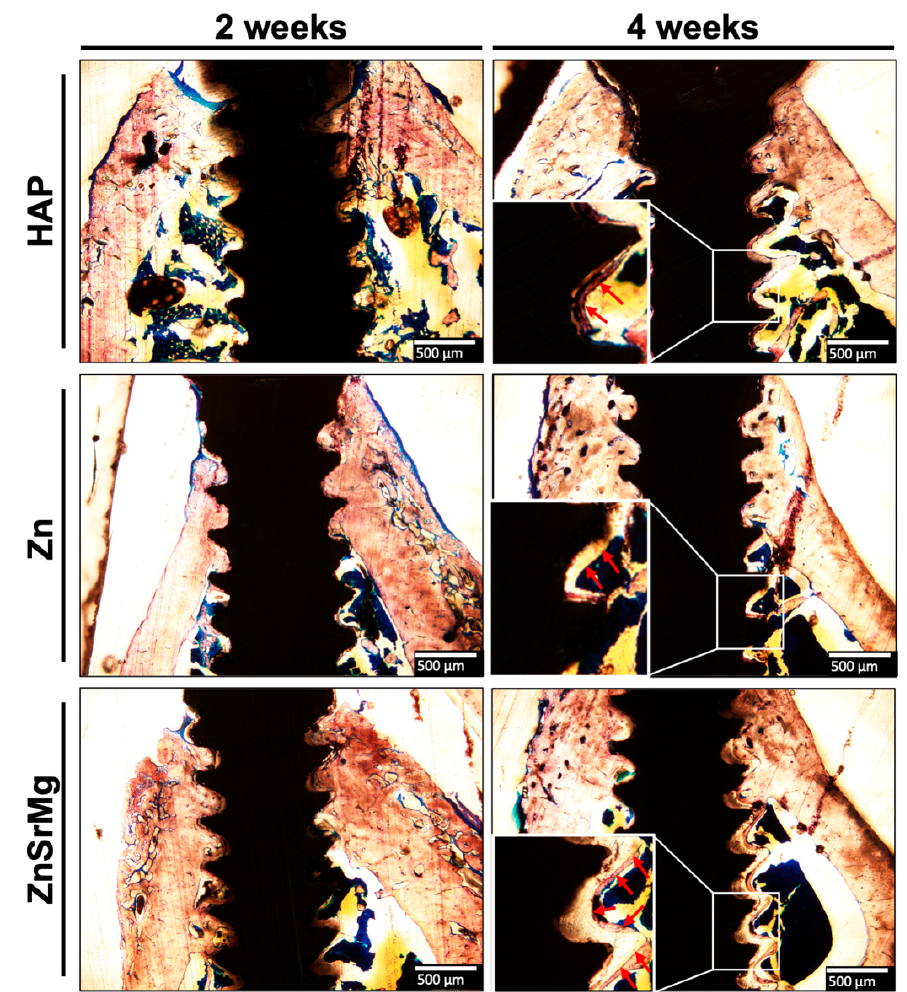
Figure 5. Histological examination of new bone formation using Stevenel’s blue and Alizarin red S. The histological results of the HAp, Zn-HAp, and ZnSrMg-HAp groups were collected at 2 and 4 weeks. (40× magnification). Continuous bone coverage on implant threads was more prominent in the ZnSrMg-HAp group, extending to the sixth thread, compared with the HAp and Zn groups. A pattern of concentrated bone growth could be clearly observed in the ZnSrMg-HAp group. Thickened bone deposition was more apparent on the implant surface in the ZnSrMg-HAp group. Red arrows indicate new bone formation (100× magnification).